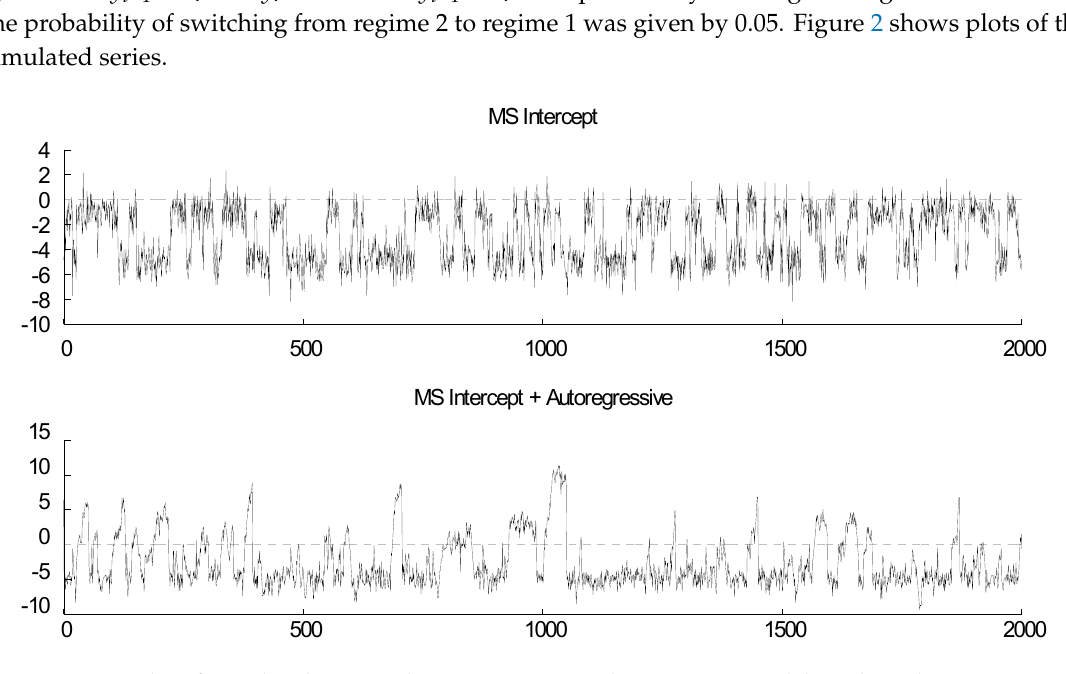
Geometric decay would be easily discerned in the bottom right plot in Figure 1 if the number of lags was set at most at 30 (or at any low amount).